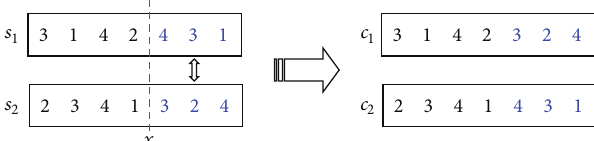
Figure 8: The single-point crossover